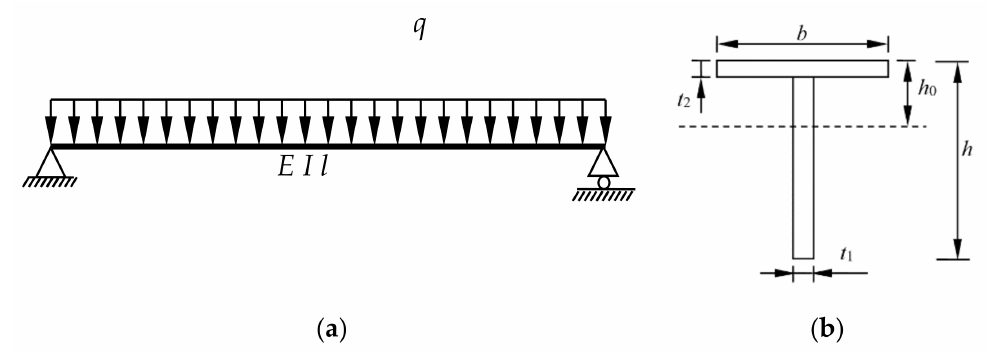
Figure 2. Schematic of the single beam. ( a ) Model of single beam, and ( b ) shape of beam